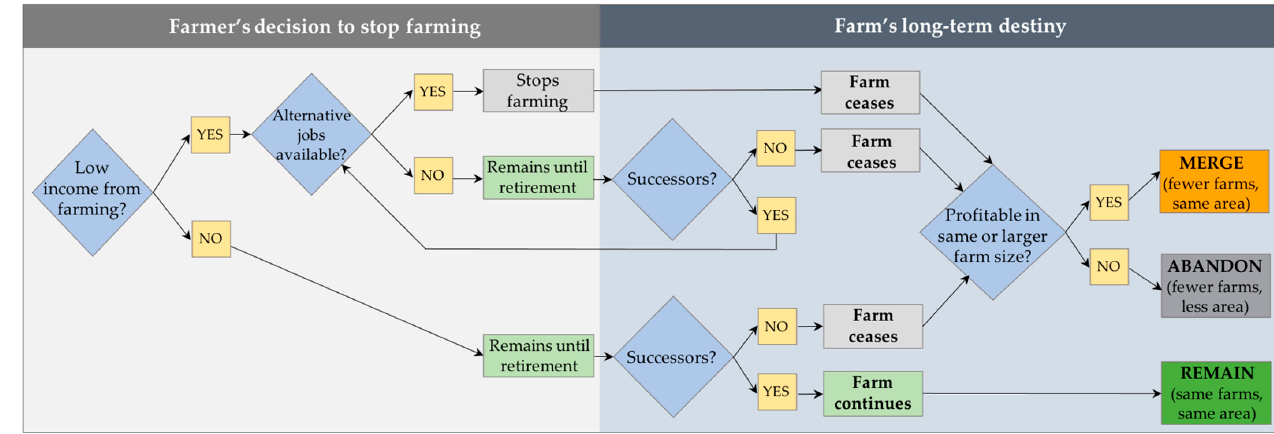
Figure 1. A general framework of farm size structural change.